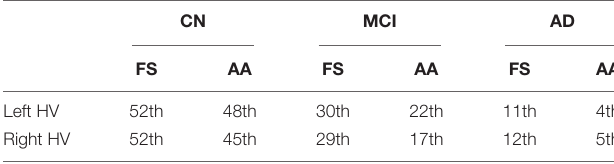
Hippocampal Volume; CN, Cognitively intact healthy control; MCI, Mild Cognitive Impairment; AD, Alzheimer’s